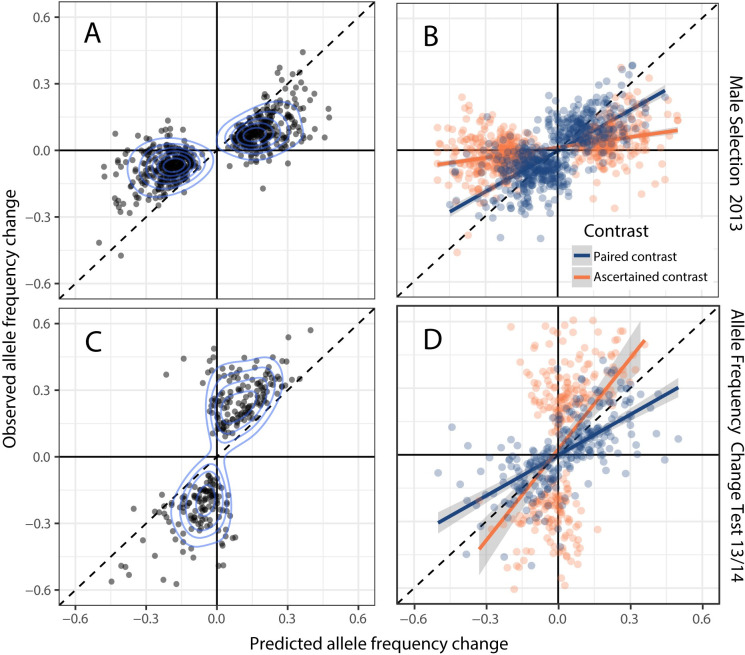
The observed allele frequency change (2013 adults to 2014 zygotes) is compared to predicted with SNPs chosen based on (A) significance for male selection in 2013 (n = 587) or (C) significance for the Change in Allele Frequency test (n = 274). Results are reported for all gene sets with a SNP with p < 10−5. Contours indicate the density of points in panels A,C. For cross-validation (B, D), we split the data into two halves and performed model fits on each half. We chose an equivalent number of SNPs to the corresponding un-partitioned analyses with n = 587 in (B) to match (A) and n = 274 in (D) to match (C). For SNPs selected based on male selection (B), the “Ascertained” contrast is based on the predicted Δp from the significant test (orange points) while the “Paired” contrast is based on the predicted Δp from the other half of the data (blue points). (D) In the cross-validation for allele frequency change significant tests, the ascertained (orange) is the observed Δp from the significant test and predicted Δp from the other data half. Assignment is reversed because the allele frequency change test is based on the observed Δp.